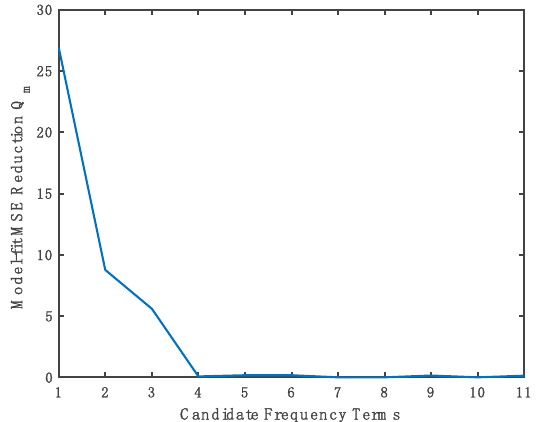
Figure 5. Model-fit MSE reduction Q m versus the number of candidate terms of modeling the measured correlation function of GPS satellite PRN